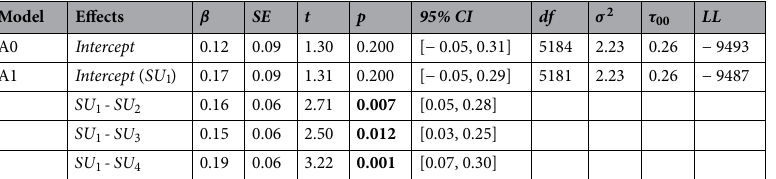
Table 1. LMM analysis of the effect of expected surprise on the pupil size during the foreperiod. β fixed effect 2 coefficient, LL Log-Likelihood, σ variance of level-1 residual errors, τ 00 variance of level-2 residual errors. Significant values are in